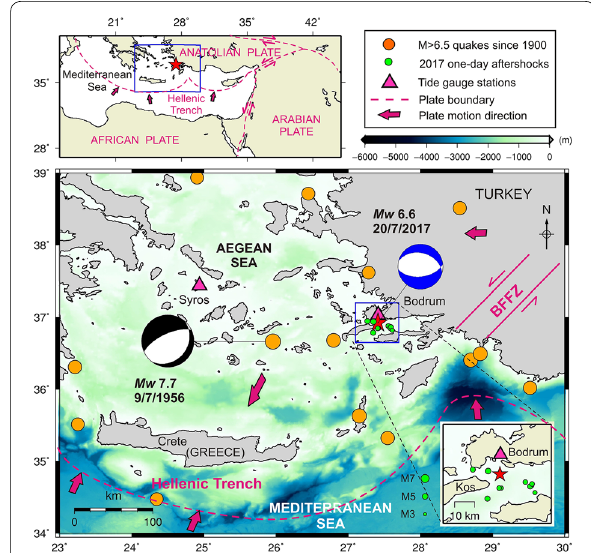
Fig. 1 Location map showing the epicenter (red star) and mecha- nism of the 20 July 2017 Bodrum–Kos earthquake. Locations of two tide gauges (Bodrum and Syros) are shown by pink triangles. Green circles show 1-day aftershocks ( M 4) from the USGS catalog. The ≥ mechanism for the 2017 event is taken from the USGS catalog. Orange circles are M 6.5 earthquakes since 1900 AD obtained ≥ from the USGS catalog. The magnitude and mechanism of the 1956 event is obtained from USGS and Okal et al. (2009), respectively. Plate motion direction arrows and fault zones shown in this figure are based on those in Ozel et al. (2011) and Ebeling et al. (2012). BFFZ Burdur–Fethiye fault